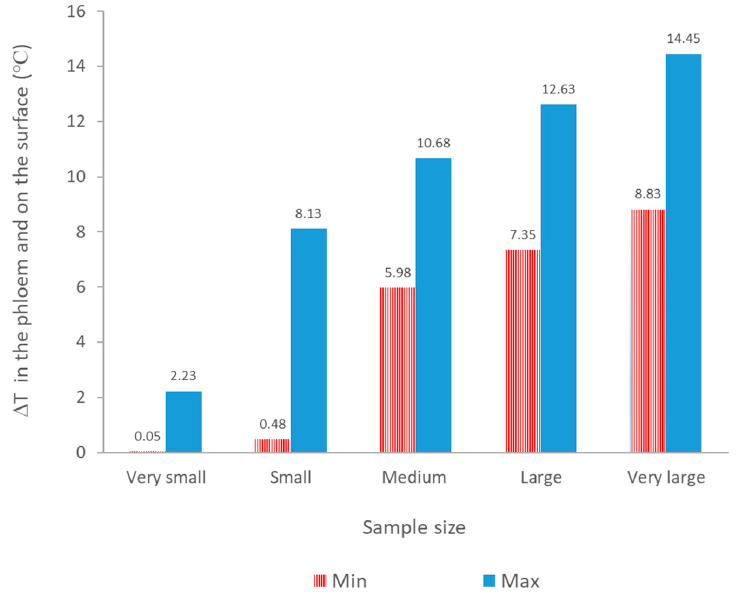
Figure 6. Temperature differences ( ∆ T) for each sample category. Table 3. The mean and standard deviation of temperature differences for each sample